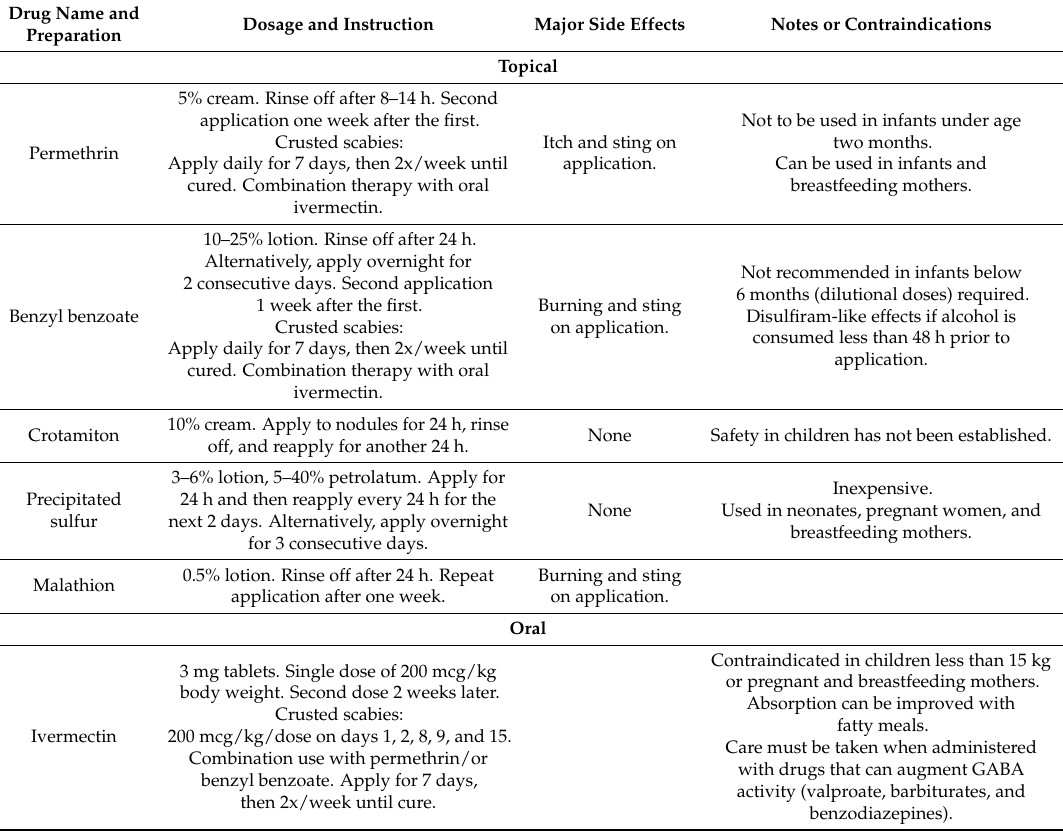
Table 2. Summary of treatments for